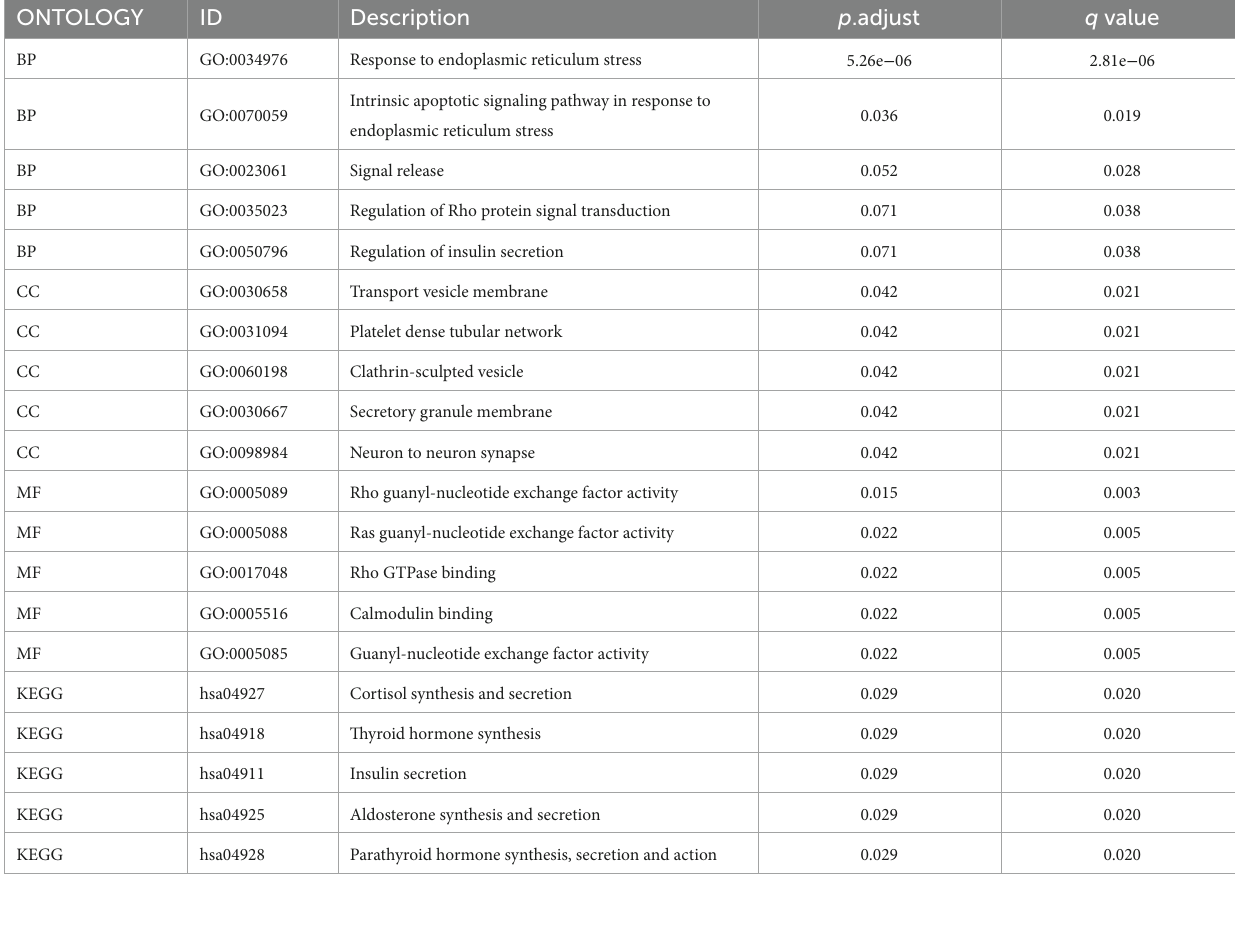
TABLE 4 GO and KEGG enrichment list of TMEM131L co-expressed hub genes. ONTOLOGY